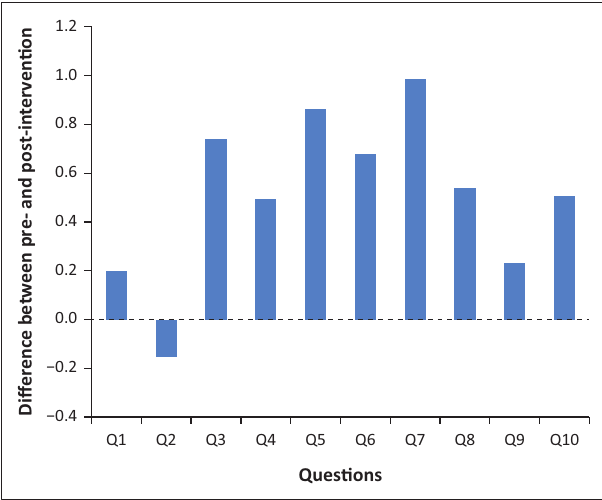
FIGURE 1: Differences between pre- and post-items for the first 10 of the 26-item